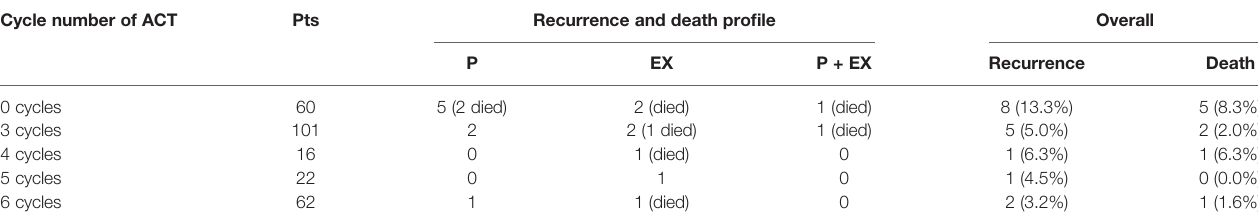
TABLE 1 | Recurrence and death rate in optimal responders according to the cycle number of postoperative ACT. Cycle number of ACT Pts Recurrence and death pro fi le